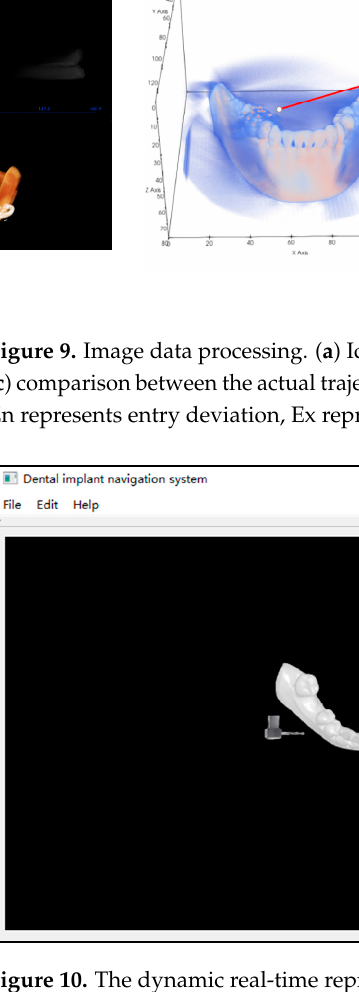
( d ) Figure 11. Deviation diagram between ideal implanting axis and actual implanting axis. The accuracy of DINS was evaluated utilising the entry, exit, and angle deviation between the implants and the planned trajectories [22], as shown in Figure 9c. Ten groups of repetitive experiments were conducted, and the results are shown in Table 1. It can be seen from the table that the mean deviation and standard deviation of the entry point are